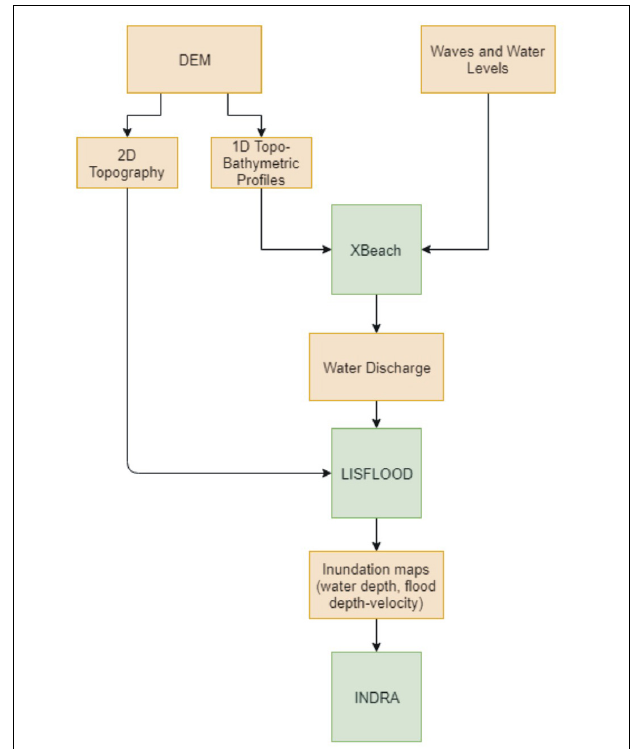
FIGURE 2 | Hazard assessment process and link between XBeach and Lisflood models.